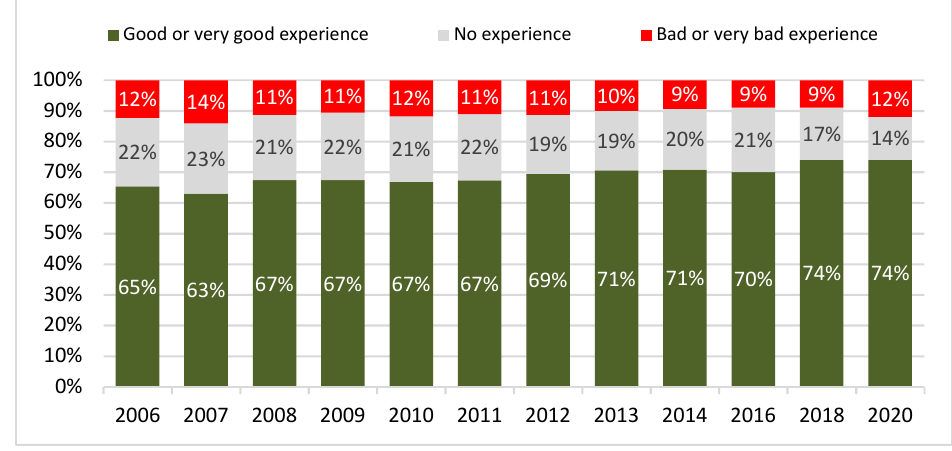
Figure 4. Experiences from working/studying with people with foreign background. Considering political party sympathy, more that 74% of sympathizers of all political parties apart from the Sweden Democrats (SD) reported good or very good experiences of working or studying with colleagues with foreign backgrounds. Notably, only 42% of SD sympathizers reported good or very good experiences, while 36% reported bad or very bad experiences. Generally, sympathizers of political parties closer to right-wing politics reported less positive experiences of working or studying with colleagues with foreign backgrounds (see Figure 5). The other parties in the figure are the Moderate Party (M), the Christian Democrats (KD), the Liberals (L), the Centre Party (C), the Green Party (MP), the Social Democratic Party (S) and the Left Party (V).